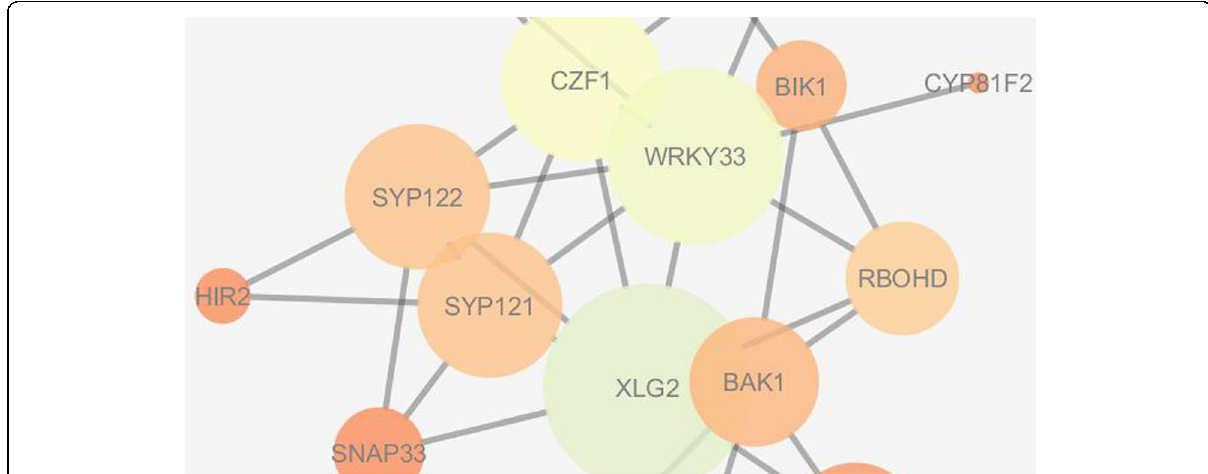
Fig. 8 Visualization of key components involved in SA-mediated resistance in Arabidopsis thaliana under contrast